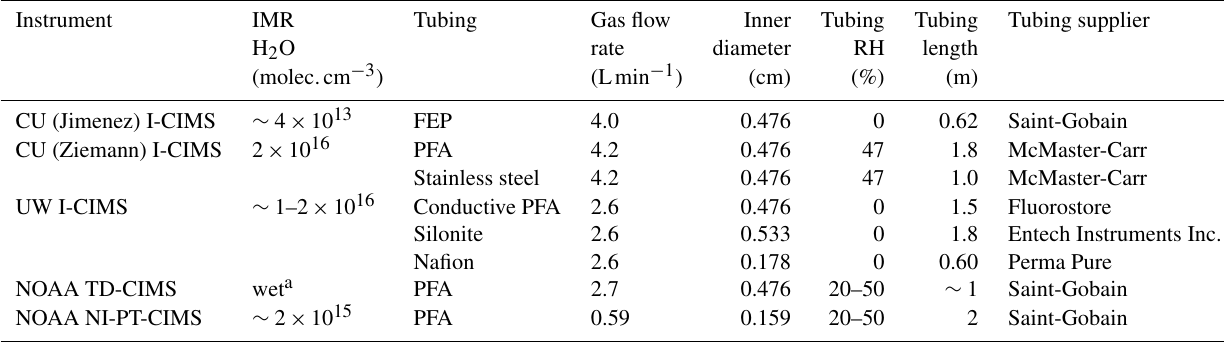
Figure 1. Example instrument-only (red, solid lines) and instrument + FEP tubing (green, solid lines) depassivation responses for three different hydroxynitrates observed by the Jimenez I-CIMS. In all cases multi-exponential decays were observed (dashed line fits), with a substantial initial fast decay, followed by a much slower decrease in the signal. Note these decays have different timescale ( τ ) values. The percentages in parentheses are fractions of original signals associated with each τ . Table 1. Instruments and tubing materials tested in this study. Instrument IMR Tubing Gas flow Inner Tubing Tubing Tubing